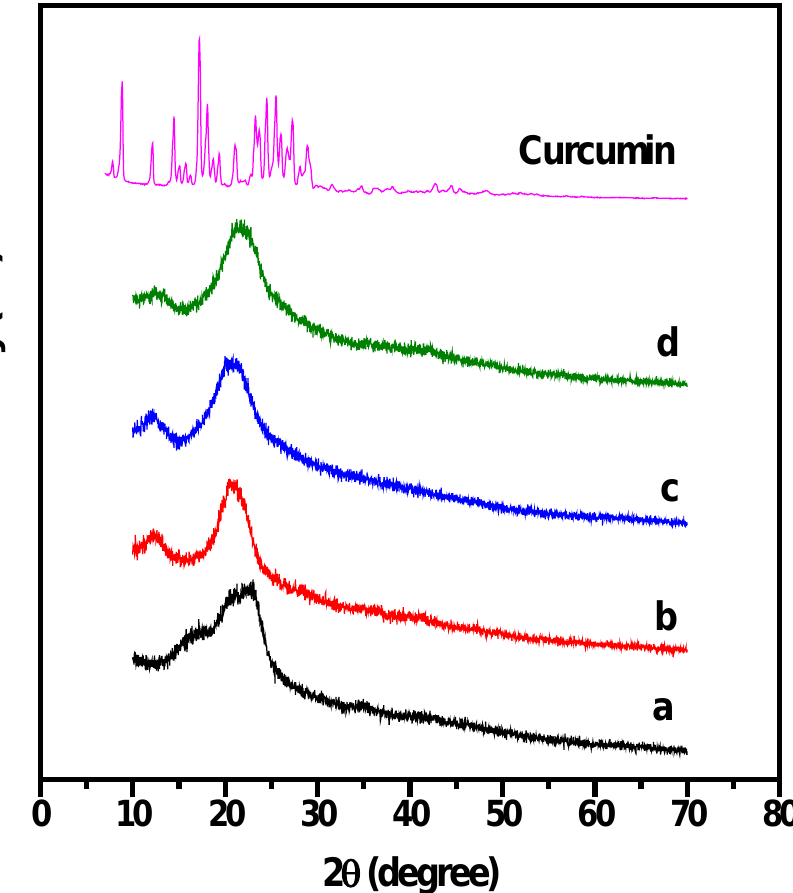
Figure 2. XRD patterns of composite films having: ( a ) only CP, ( b ) 1:0.5 CP/PU, ( c ) 1:1 CP/PU, and ( d ) 1:1 CP/PU with 10 wt% curcumin.